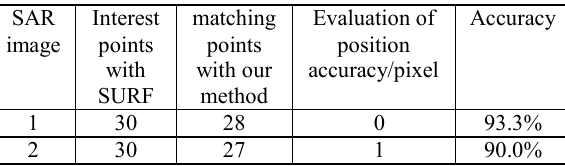
Table 2. Test results of SAR image with our method